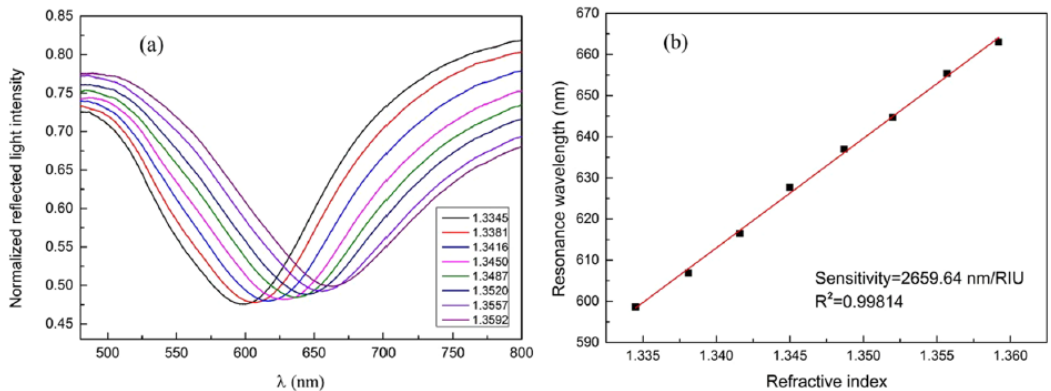
Figure 5. ( a ) Reflection spectra (normalized) of NaCl solutions with different refractive indices (RIs). ( b ) Experimental relationship between resonance wavelength location and RI of the solution. Figures reproduced under the terms of the CC-BY Creative Commons attribution 4.0 from Reference [28], Copyright 2017.